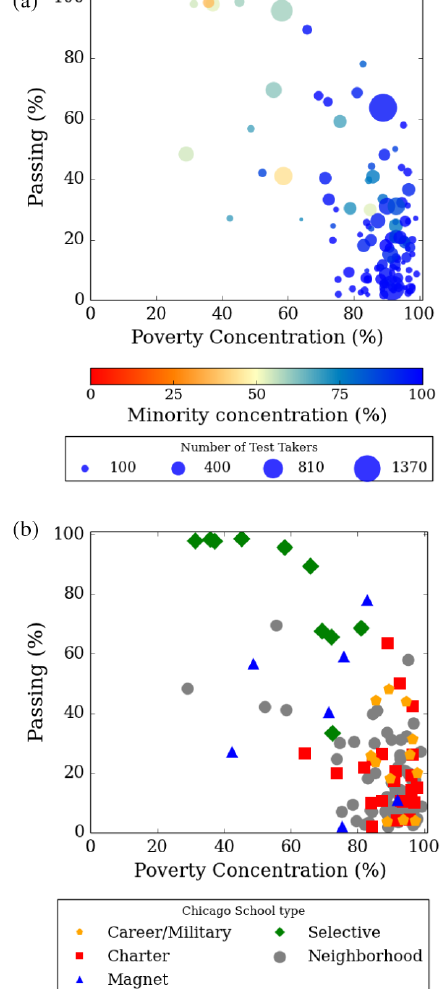
FIG. 2. (a) Percent of 11th graders at Chicago schools only who passed the 2013 Math PSAE as a function of poverty concen- tration. The size and color of the points represent the number of test takers and percent of minority students, respectively. (b) Chicago schools are again presented; in this case, symbols indicate the type of school as given in the